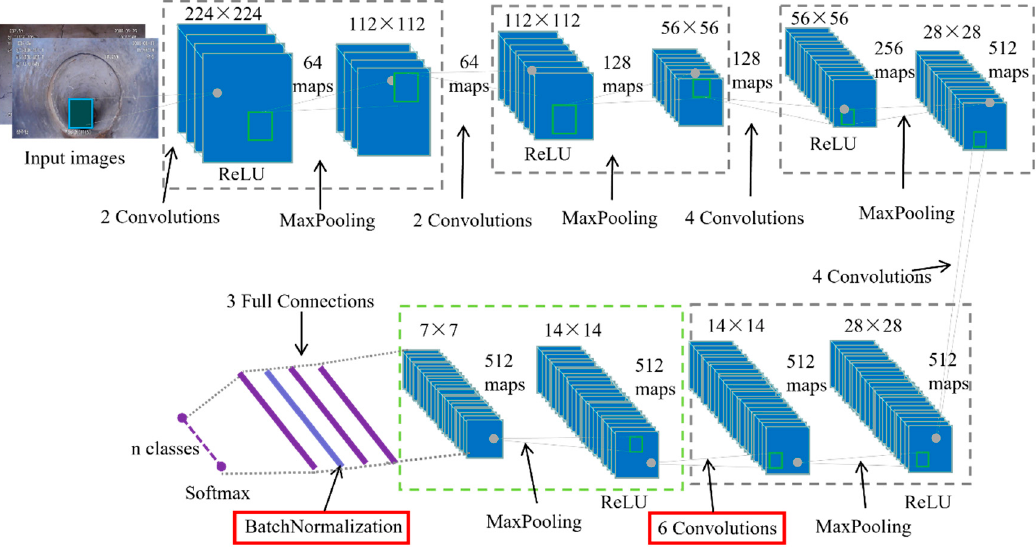
Figure 7. A fine-tuned network architecture used for defect classification. Table 2. Academic studies in vision-based defect classification algorithms.